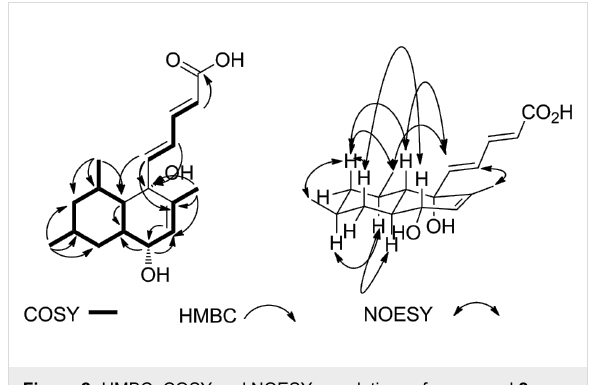
Figure 2: HMBC, COSY and NOESY correlations of compound 2